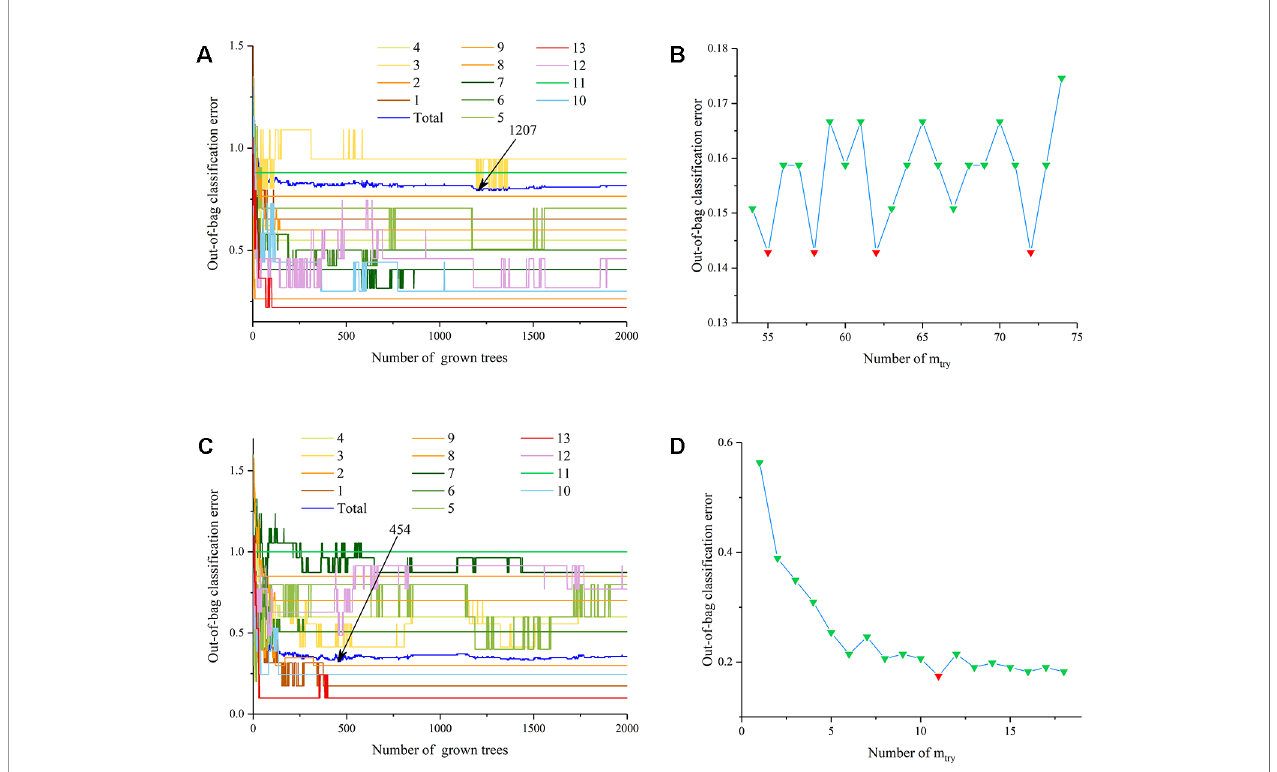
FIGURE 10 | The parameter optimization of random forest models (A) : n tree of the low-level data fusion dataset; (B) : m try of the low-level data fusion dataset; (C) : n tree of the mid-level data fusion dataset; (D) : m try of the mid-level data fusion